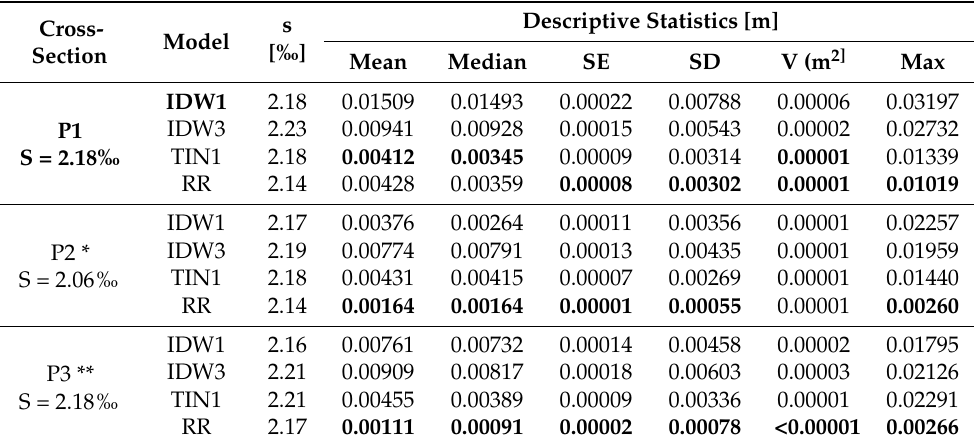
Table 4. Descriptive statistics of absolute deviation of considered models (cross-sections P1, P2, and P3) from the average linear slope.